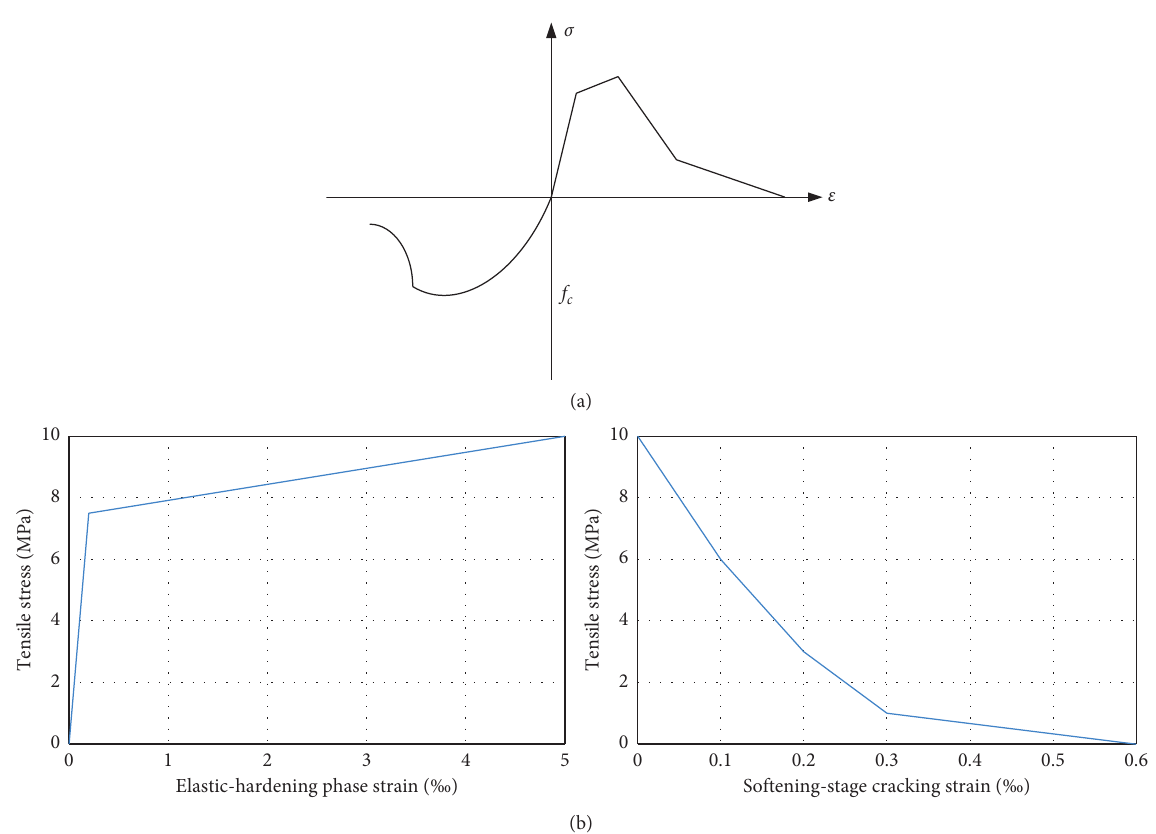
Figure 5: Constitutive relation model of the UHPFRC. (a) Tensile and compression constitutive model of the UHPFRC. (b) Tensile constitutive relation in the numerical model of the UHPFRC.